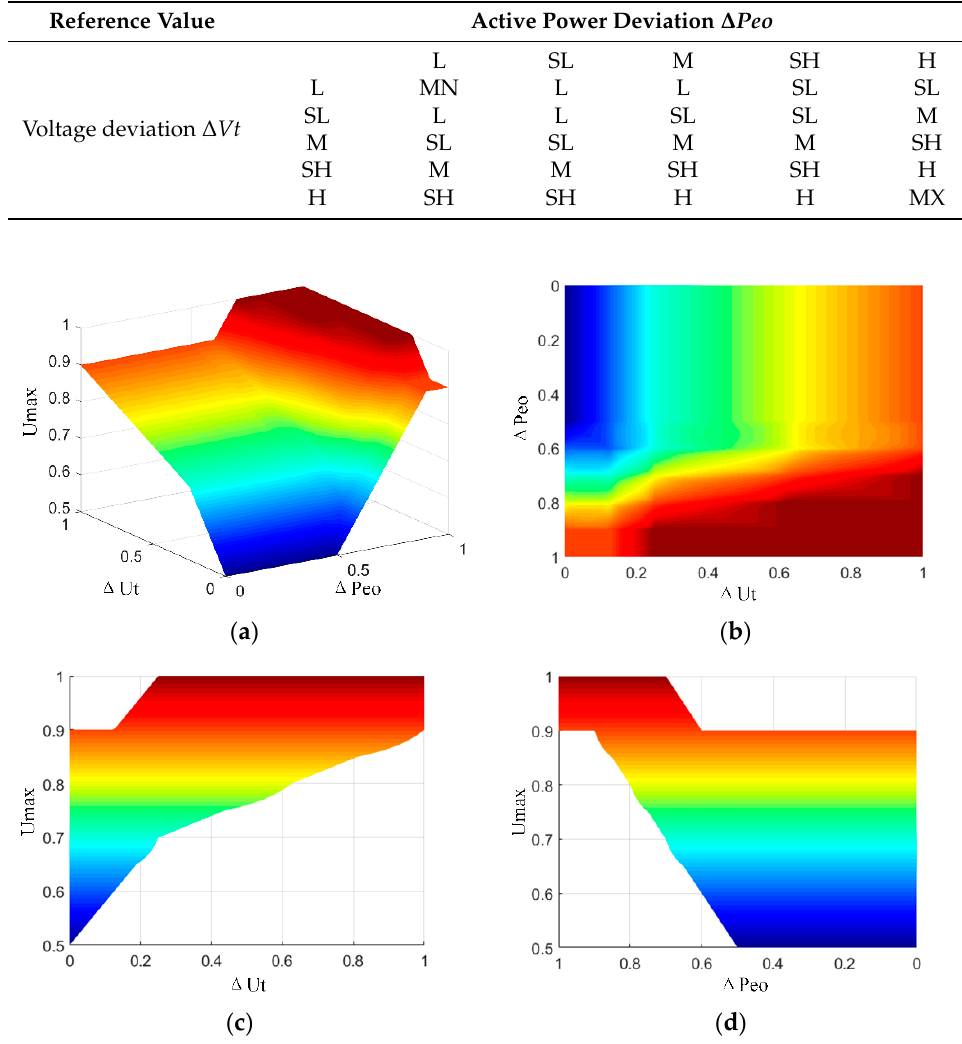
Figure 4. Fuzzy control membership function. ( a ) three-dimensional view ( b ) relationship of Δ Peo and Δ Ut ( c ) relationship of U max and Δ Ut ( d ) relationship of U max and Δ Peo . Table 1. Fuzzy Control Rules for Amplitude Limiter. To avoid frequent mode switching between interval 1 and interval 2, the dead zone was designed in Equation (31). Where Switch is the signal for mode switching, while Switch = 0, the LOEC + AAL was adopted, otherwise the mode was LOEC. In Equation (31), ∆ Pe ∆ Pe ∆ Vt ∆ Vt 0 > 1 and 0 > 1 : the Schmitt